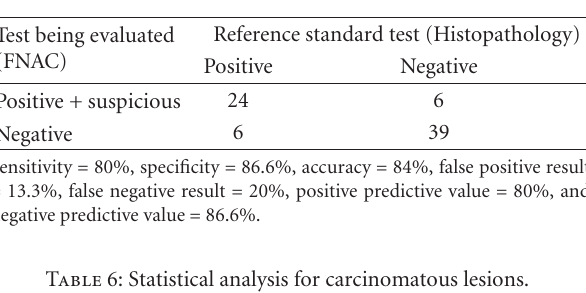
Table 5: Statistical analysis for neoplastic lesions.